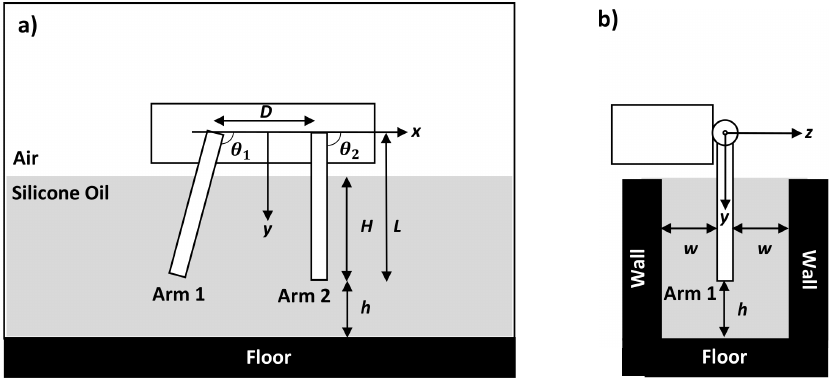
Figure 2. ( a ) The arms are at a distance h away from the floor. ( b ) When vertical walls were introduced, they were at a distance w from the